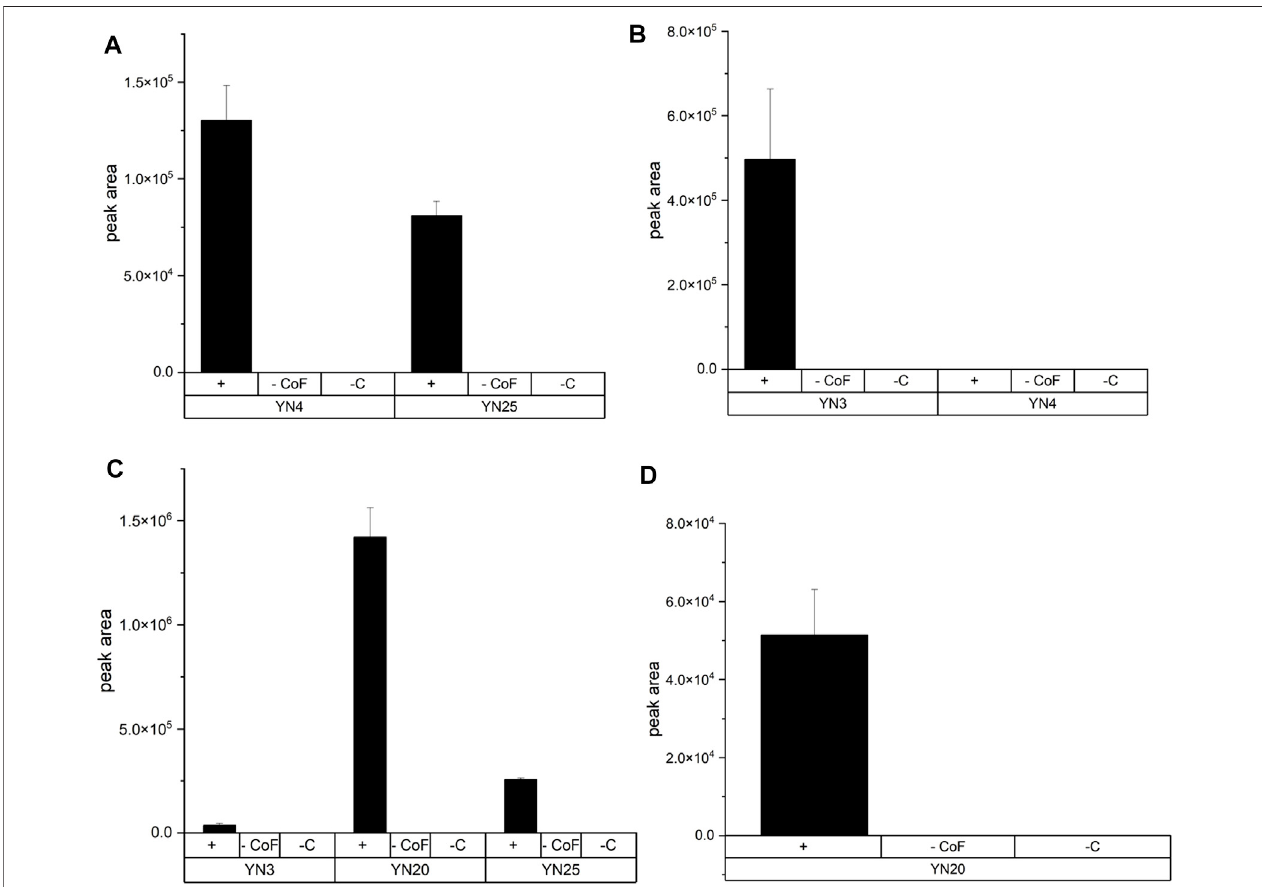
FIGURE3| ProductionofthreedifferentsulfoconjugatedmetabolitesbyvarioushumanSULTs.Experimentalconditionsaredescribedinthetext.Namesof fi ssion yeaststrainaregiveninbrackets.+:incubationwithcellsandcofactors — CoF:incubationwithoutcofactorsbutwithcells — C:incubationwithoutcellsbutwithcofactors. (A) Production of DHEASU from DHEA. (B) Production of 7HCSU from 7HC. (C) Production of 4HPSU from 4HP. Each experiment was done in triplicates. (D) Production of SASU from SA.